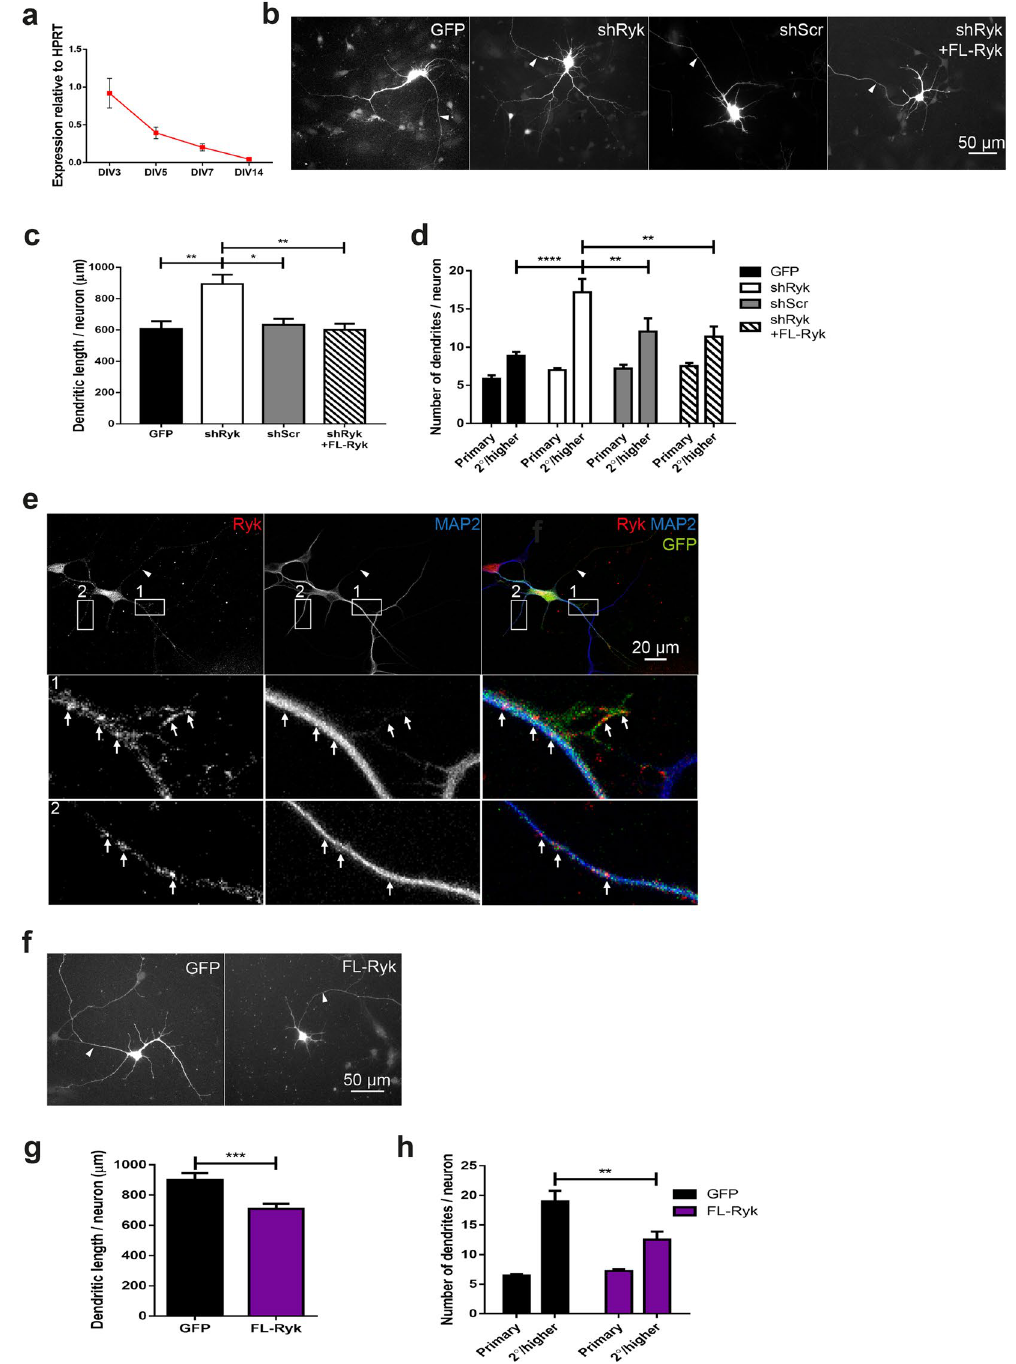
Figure 2. Ryk inhibits dendritic growth and branching in cultured hippocampal neurons. ( a ) Quantitative PCR showed that Ryk was expressed in cultured hippocampal neurons. HPRT, hypoxanthine guanine phosphoribosyl transferase. ( b , c , d ) Plasmids containing Ryk-specific shRNA (shRyk) or control shRNA (shScr) and GFP were transfected into DIV3 hippocampal neurons and dendritogenesis assessed at DIV5. Depletion of Ryk resulted in an increase in dendritic length ( b , c ) and the number of secondary and higher order (2°/higher) dendrites ( b , d ). Coexpression of shRNA-resistant FL-Ryk with shRyk fully rescued dendritic growth and branching (n = 6; 50–60 neurons/condition; * p < 0.05; ** p < 0.01; **** p < 0.0001). ( e ) When transfected alone, FL-Ryk, identified by an anti-Myc antibody, localized to the dendritic shaft and filopodia of hippocampal neurons. Dendrites were identified using anti-MAP2. Bottom panels 1 and 2 are enlargements of insets. Arrows point to FL-Ryk clusters. Overexpression of FL-Ryk alone in hippocampal neurons led to a decrease in dendritic length ( f , g ) and 2°/higher order branching ( f , h ) (n = 6; 50–60 neurons/condition; ** p = 0.0015; *** p = 0.0008). Data are represented as the mean ± s.e.m. ( b , e , f ) Arrowheads indicate the